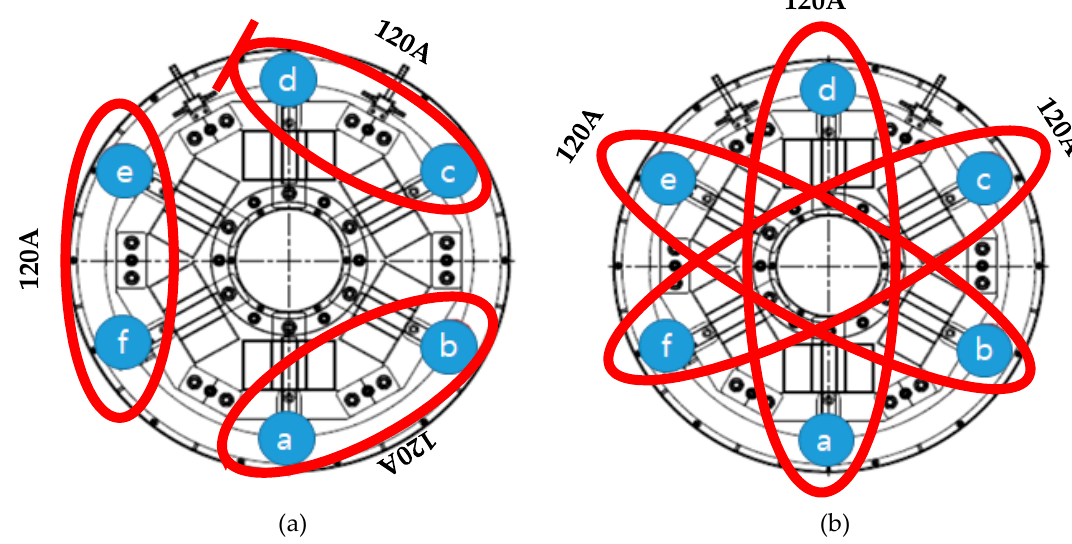
Figure 4. Scheme magnetic current input method: ( a ) adjacent pole counterclockwise (CAMP); ( b ) counterclockwise of symmetry magnetic pole (CSMP).